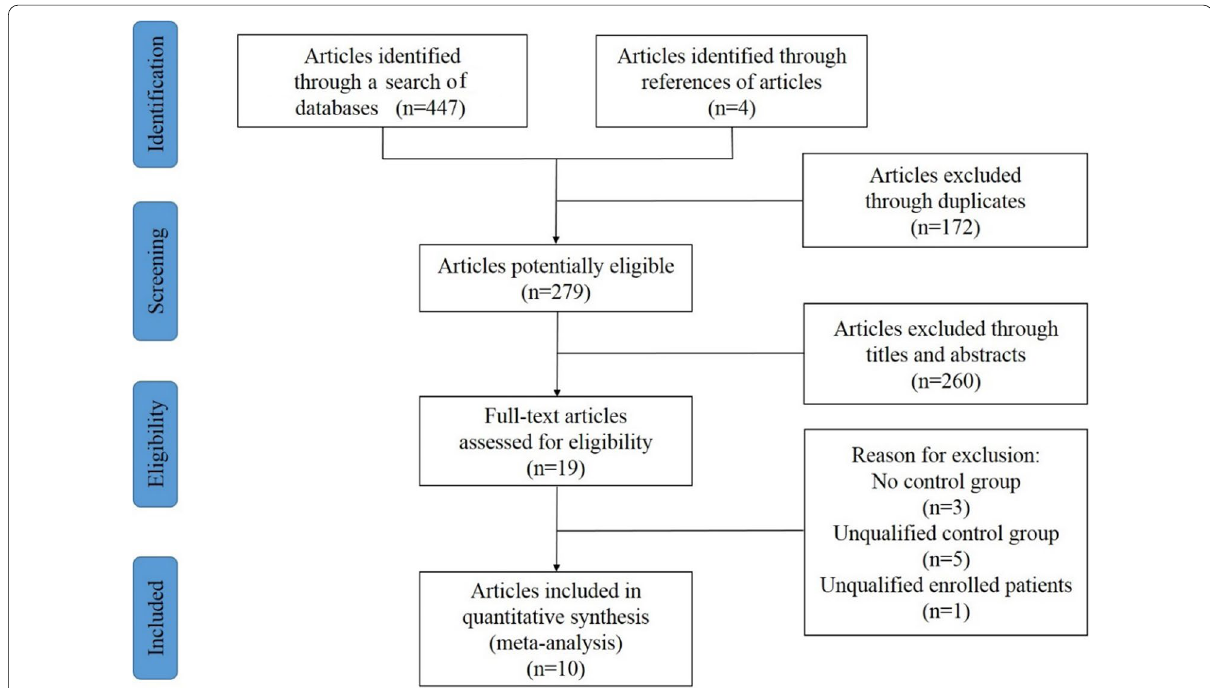
Fig. 1 Flow diagram of the selection process for the included